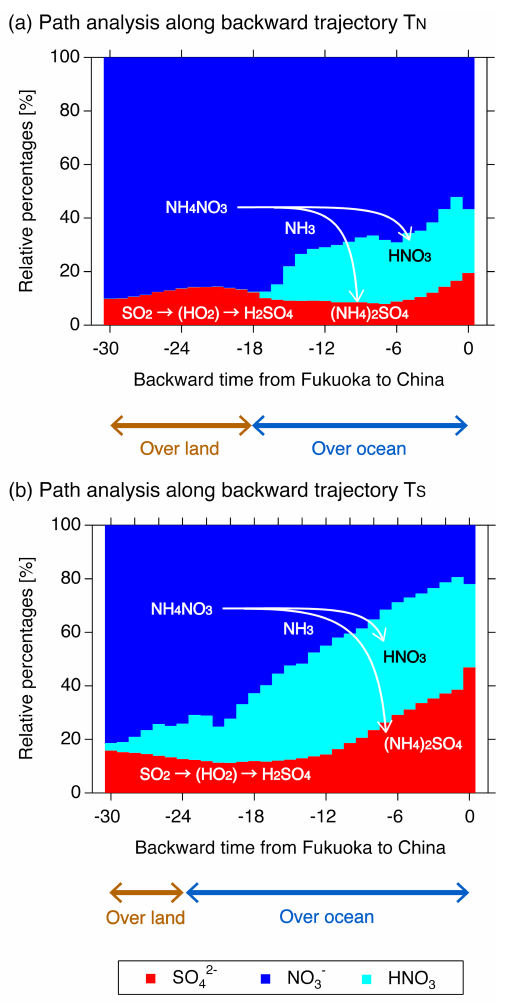
Figure 13. The path analysis of the model results along trajectories T N and T S . The percentages of each concentration relative to the sum of the SO 2 − , NO − , and HNO 3 concentrations in equivalent 4 3 units are shown. The time axis indicates the backward time from Fukuoka. The brown and blue bars at the bottom are schematics of the trajectory location over land and ocean.